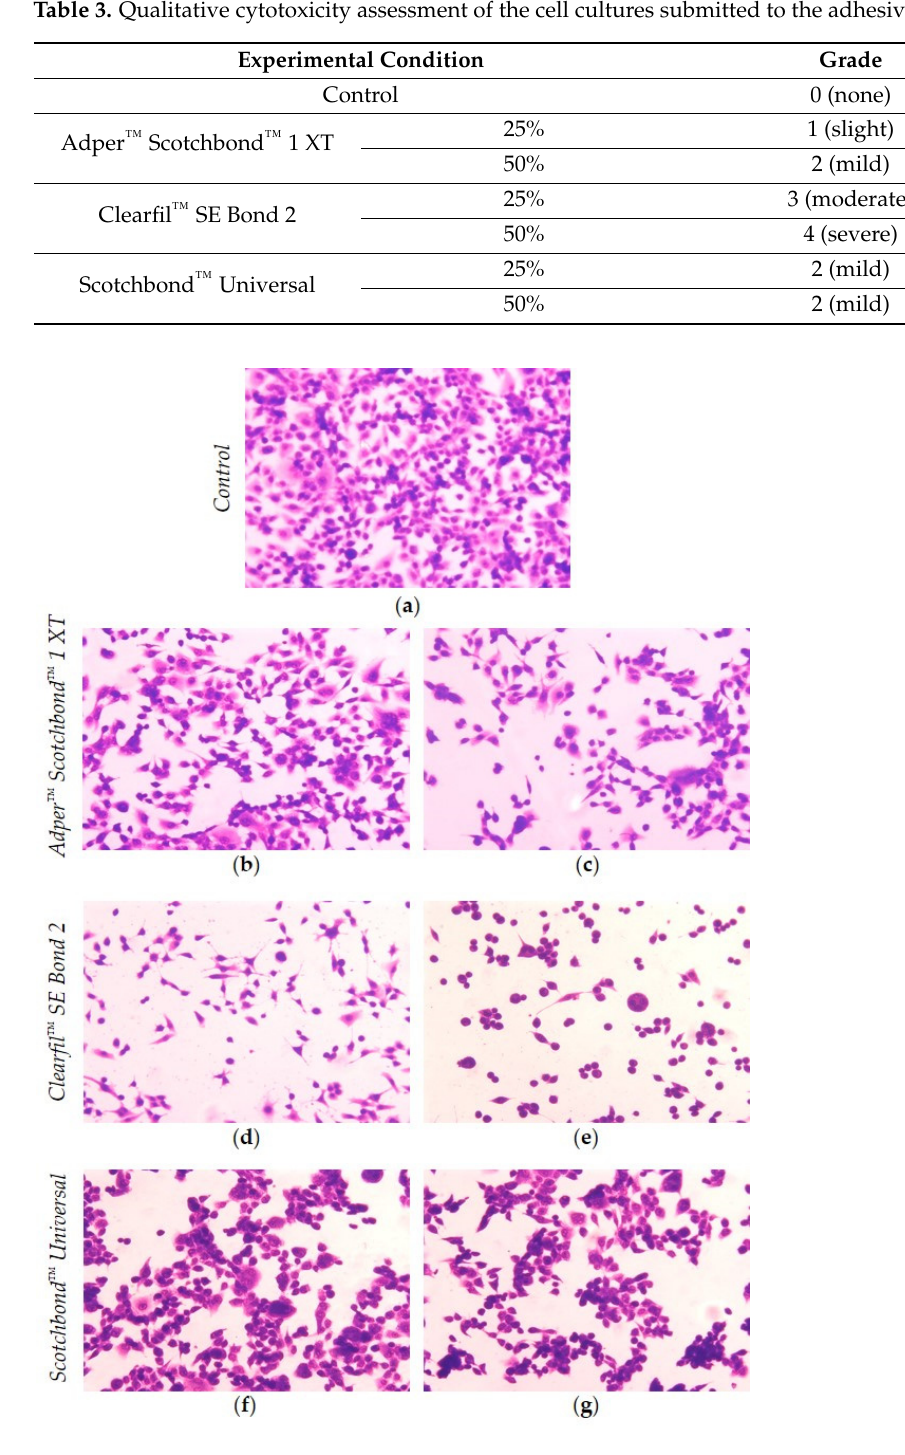
Figure 5. MDPC-23 cells after May-Grünwald Giemsa staining. The photographs represent control cultures submitted to DMEM ( a ) and cultures submitted to the extracts of Adper ™ Scotchbond ™ 1